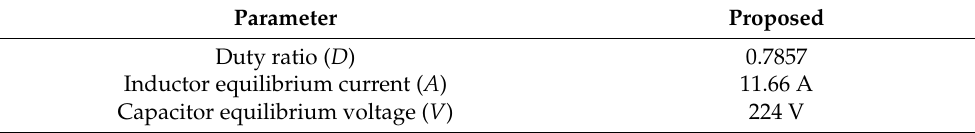
Table 2. Equilibrium points of the proposed converter’s module.